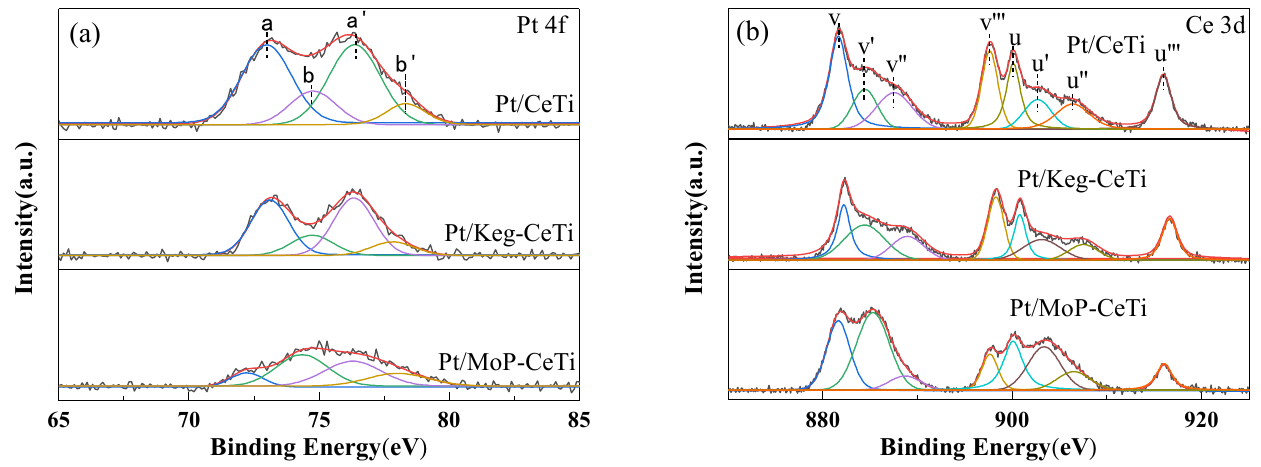
Figure 7. XPS spectra of Pt 4f ( a ) and Ce 3d ( b ) in the Pt/CeTi, Pt/Keg-CeTi, and Pt/MoP-CeTi catalysts. It was observed that the binding energy values of Pt 4f in the three samples were different (Figure 7a). The peaks were labeled as “a” and “b,” representing Pt 2+ and Pt 4+ [50], respectively. This suggested that Pt 2+ and Pt 4+ coexisted on the three catalysts’ surface with different surface atomic concentrations and atomic ratios, and no Pt 0 species were detected. The surface atomic concentrations of Pt for Pt/CeTi, Pt/Keg-CeTi, and Pt/MoP-CeTi were 0.23%, 0.16%, and 0.11% (Table 2), respectively, revealing that the addition of molybdophos- phate with or without the Keggin structure resulted in a decrease in the surface active sites. This might be one reason why Pt/CeTi has the best catalytic activity in the absence of H 2 O and SO 2 . The atomic ratios of Pt 4+ /(Pt 2+ + Pt 4+ ) for Pt/CeTi, Pt/Keg-CeTi, and Pt/MoP-CeTi were 23.3%, 24.7%, and 55.7% (Table 2), indicating that the introduction of molybdophosphate with the Keggin structure had no obvious effect on the Pt valence state. However, the Pt valence state of Pt/MoP-CeTi changed a lot. During the destruc- tion of the Keggin structure under high temperature, more Ce 3+ species were generated,